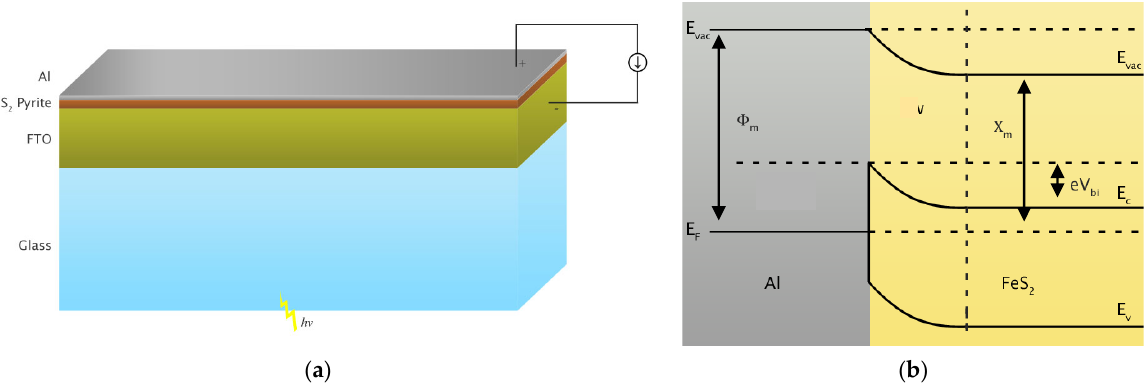
Figure 15. ( a ) A schematic representation of the final solar cell structure; ( b ) the estimated band diagram of the Schottky ‐ type solar cell. Notice the bending of the valence (E V ) and conduction (E C ) bands of pyrite in contact with aluminum.